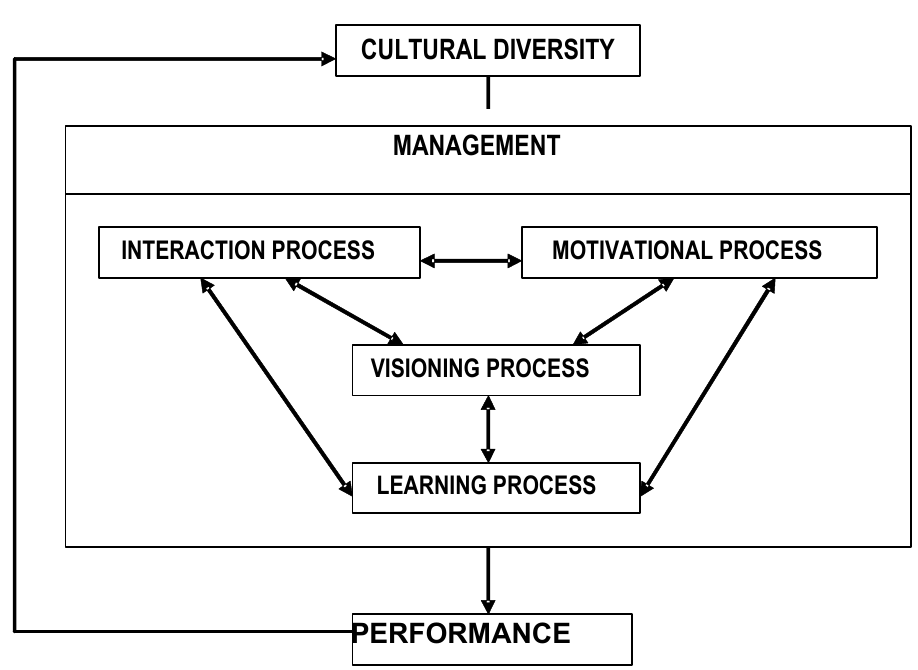
Figure 1: Influences of cultural diversity on